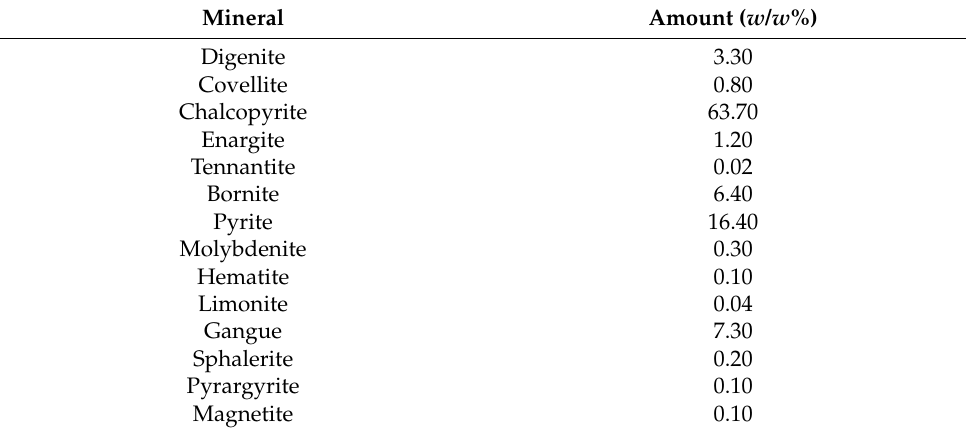
Table 1. Mineral characterization of the copper concentrate.